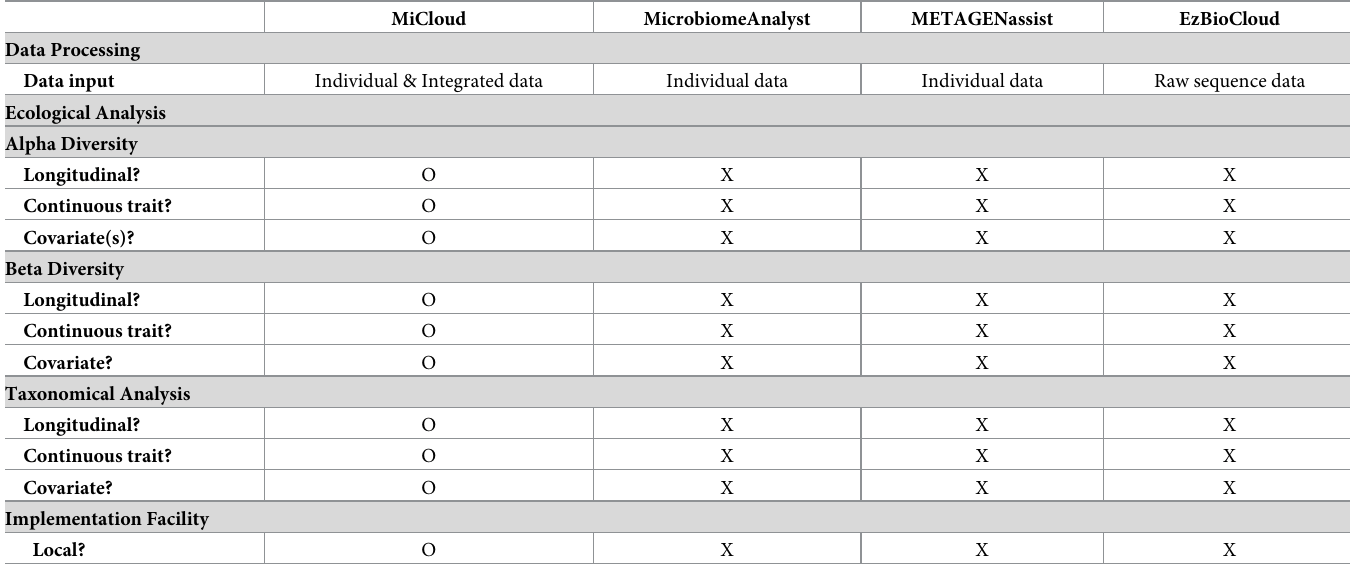
Table 1. The characteristics of MiCloud distinguished from the other existing web platforms, MicrobiomeAnalyst [33], METAGENassist [34] and EzBioCloud